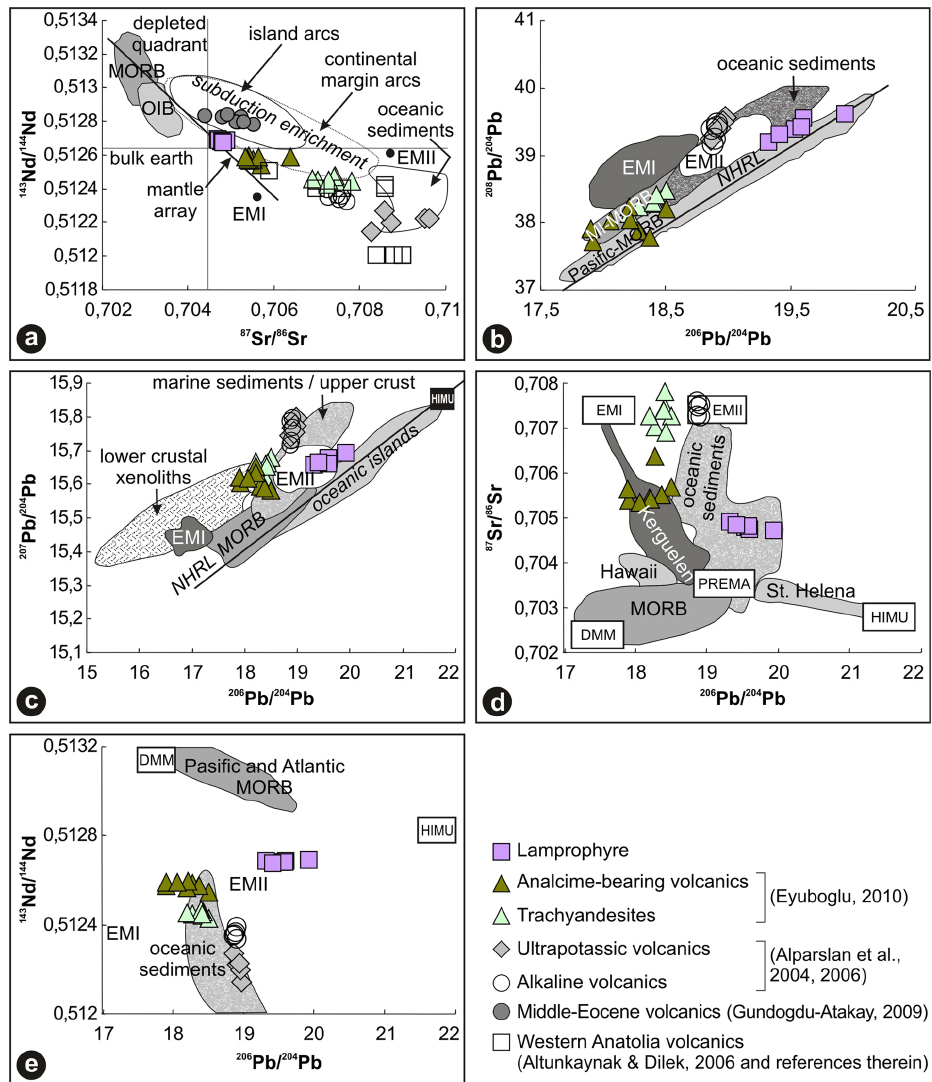
Fig. 19. Isotope variation diagrams for the Upper Cretaceous–lower Paleocene high-K island arc rocks. (a) 143 Nd/ 144 Nd vs. 87 Sr/ 86 Sr diagram. (b) 206 Pb/ 204 Pb vs. 208 Pb/ 204 Pb diagram. (c) 206 Pb/ 204 Pb vs. 207 Pb/ 204 Pb diagram. (d) 87 Sr/ 86 Sr vs. 206 Pb/ 204 Pb diagram. (e) 143 Nd/ 144 Nd vs. 206 Pb/ 204 Pb diagram. Compositional fields for the upper and lower crust, MORB (mid-ocean ridge basalt), HIMU (enriched mantle in U and Th relative to Pb), OIB (ocean island basalt), EMI (enriched mantle I) and EMII (enriched mantle II) are from Zindler and Hart (1986). The field for oceanic islands is from White (1985). NHRL = Northern Hemisphere reference